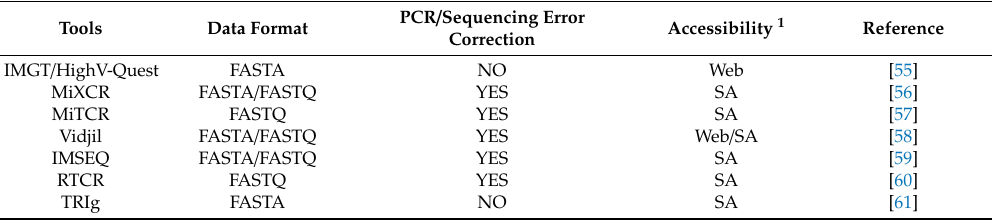
Table 2. Exemplary bioinformatics tools for TCR repertoire